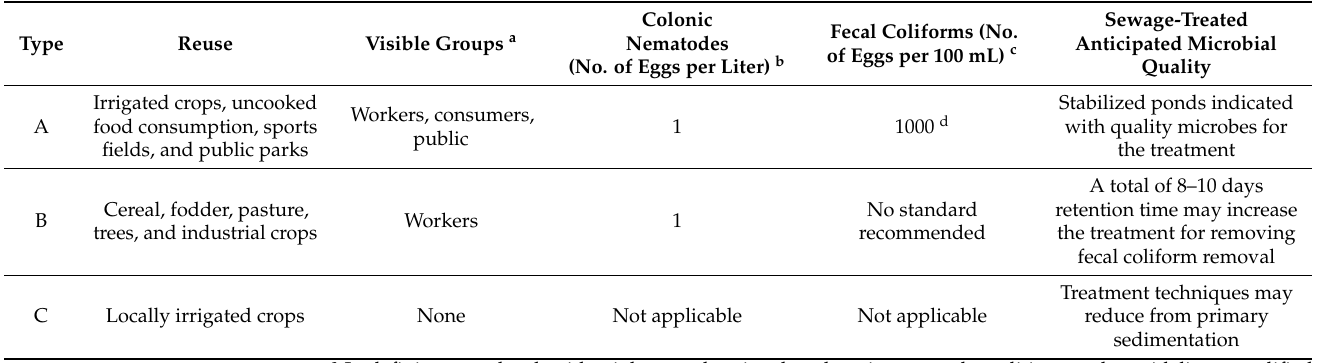
Table 7. Microbial contamination using domestic wastewater for irrigation proposes